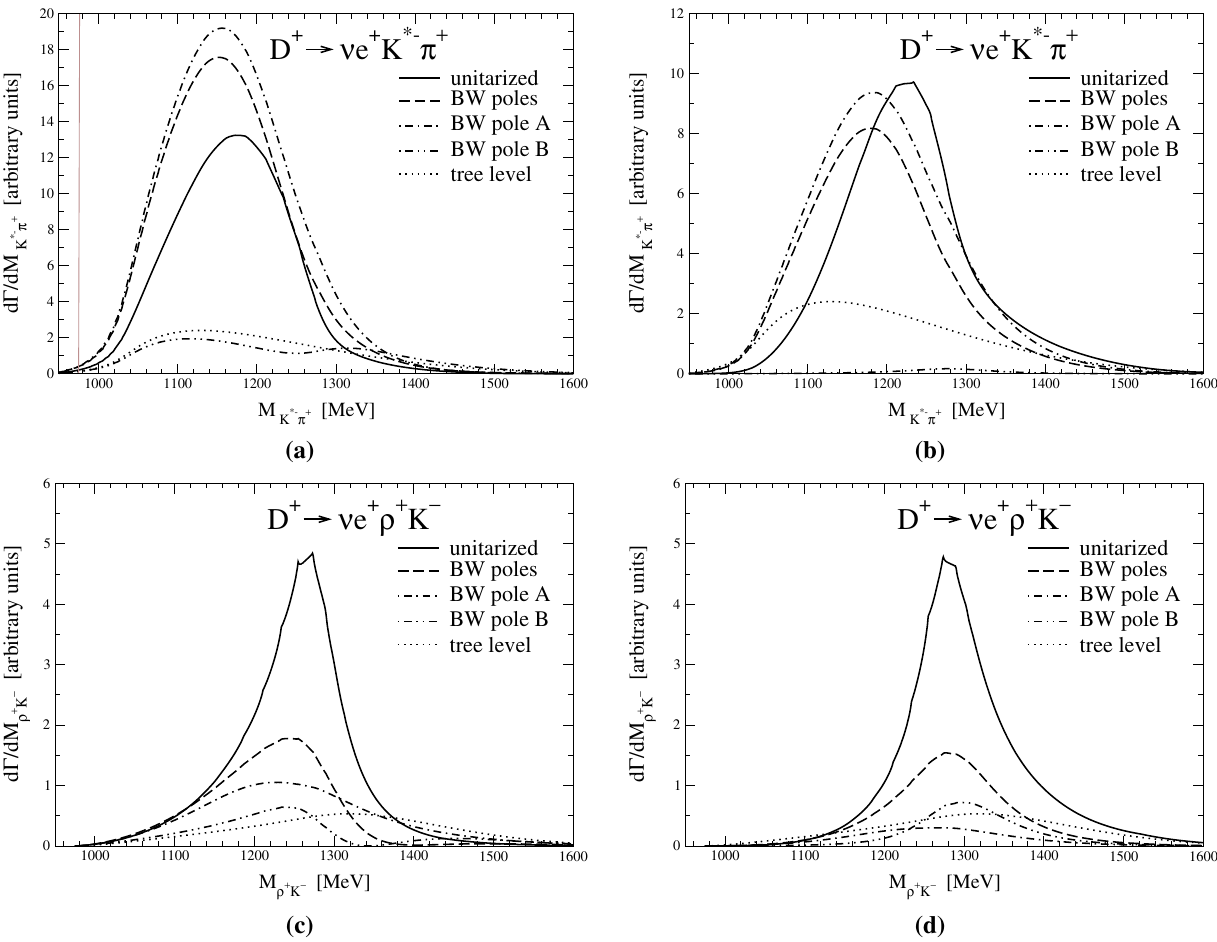
Fig. 3 V P invariant mass distributions for D + → ν e + K ∗− π + and D + → ν e + ρ + K − . Left panels, a , c including the interaction with the tree level mechanism of Fig. 1. Right panels, b , d without the interference with the tree level